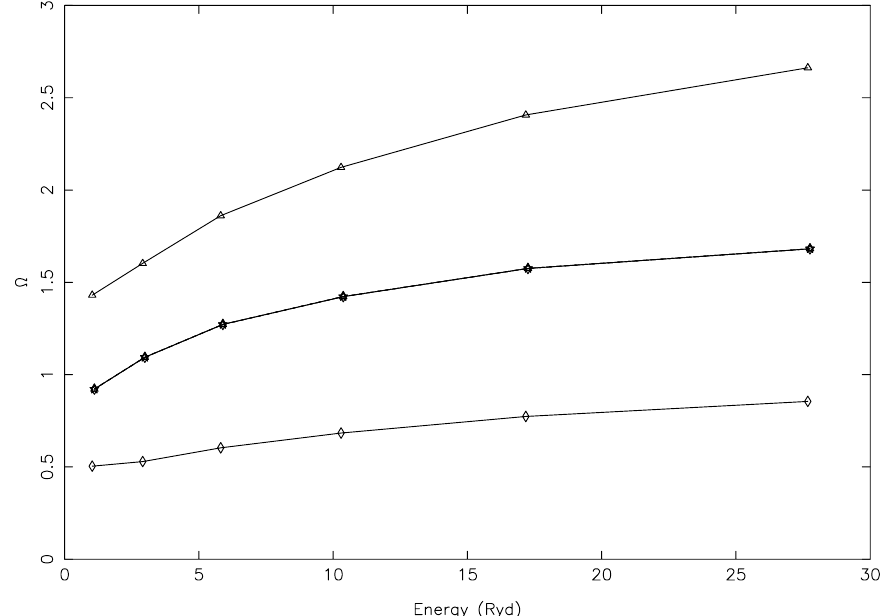
Figure 5. Our calculated values of Ω with FAC for the 3–10 (triangles: 3p 2 3 P 2 –3s3p 3 ( 2 P) 3 P o